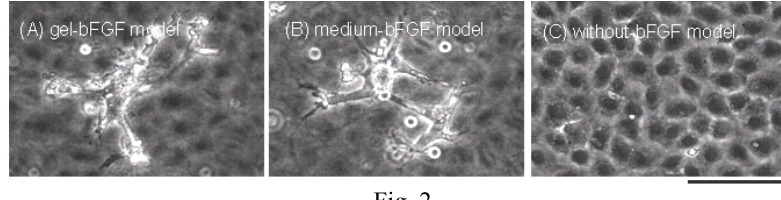
Phase-contrast images of (A) gel-bFGF model and (B) medium-bFGF model. Both models showed network formation in the collagen gel. (C) Model without bFGF in both collagen gel and medium, showing almost no network formation. Bar scale: 100 µ m.